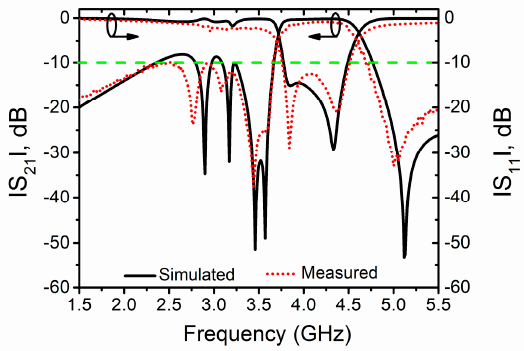
Figure 11. Filter responses of Case F ( C F = 1.5 pF, C S = 100 pF, C T = 100 pF).